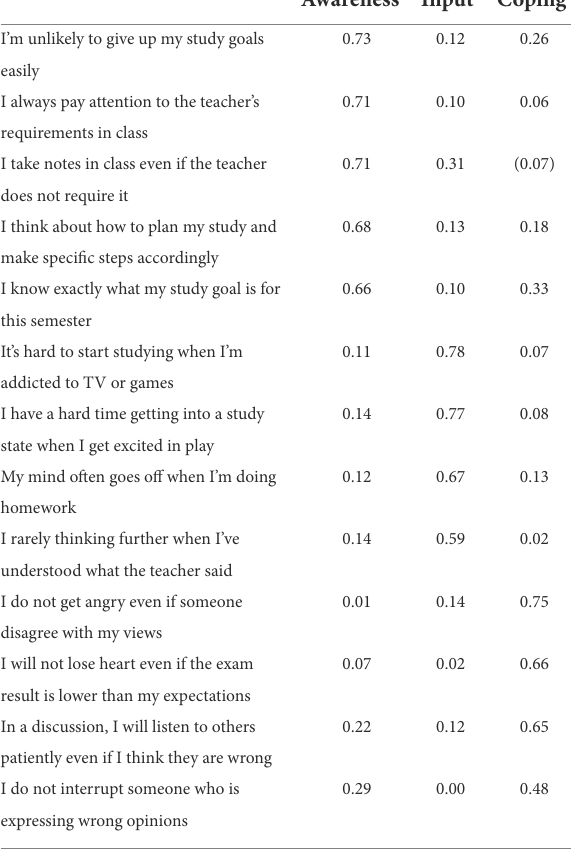
TABLE 2 Exploratory Factor Analysis (EFA) on Final 13 Student Conceptual Level Items ( n = 624). (Sample 1)